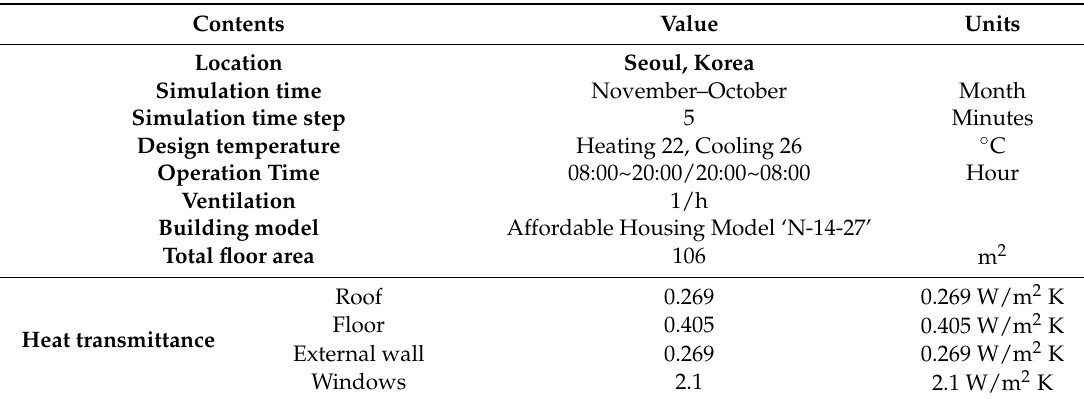
Table 1. Basic simulation design parameter.